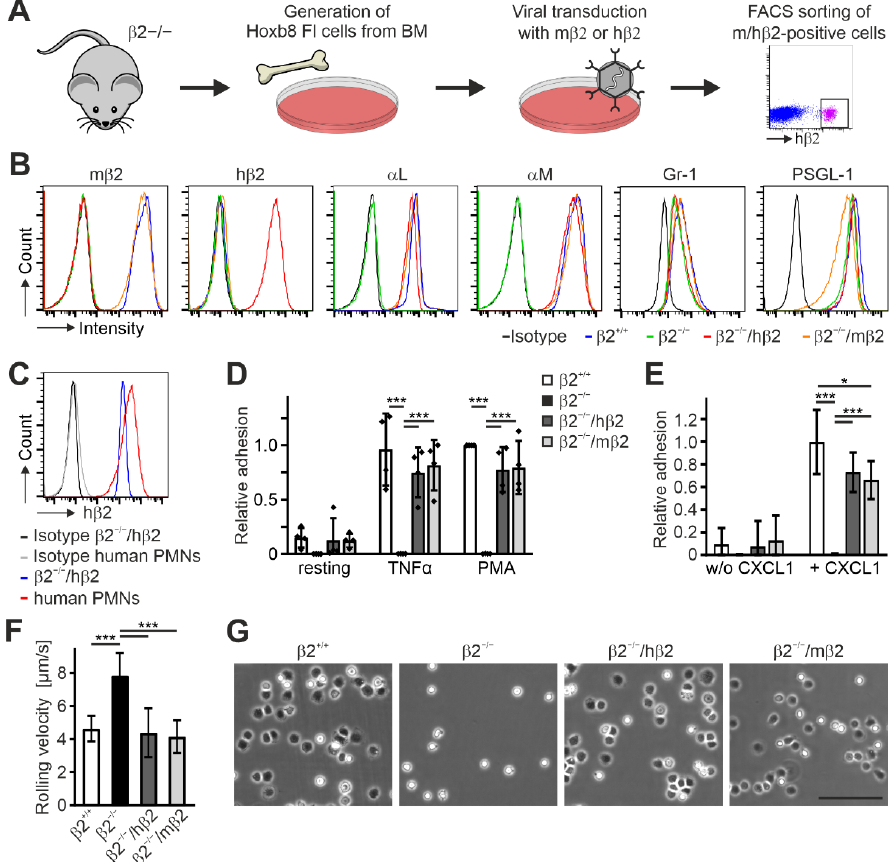
Figure 1. Integrin β 2 can be substituted by its human homolog in mouse Hoxb8 FL cells. ( A ) Scheme of workflow. Hoxb8 FL cells were generated from bone marrow of integrin β 2-deficient mice and retrovirally transduced with mouse or human integrin β 2. Human/mouse integrin β 2-positive cells were FACS-sorted. ( B ) Surface expression of different integrin subunits and cell markers on neutrophil-like cells differentiated from control ( β 2 +/+ ), integrin β 2 ko ( β 2 − / − ), and human or mouse integrin β 2-rescued integrin β 2 − / − ( β 2 − / − /h β 2 and β 2 − / − /m β 2) Hoxb8 FL cells assessed by FACS analysis. ( C ) Integrin β 2 surface expression levels on neutrophil-like cells differentiated from integrin β 2 − / − Hoxb8 FL cells retrovirally transduced with human integrin β 2 ( β 2 − / − /h β 2) compared to PMNs isolated from human blood. ( D ) Static adhesion of untreated, TNF α -treated, or PMA-treated Hoxb8 FL-derived β 2 +/+ , β 2 − / − , β 2 − / − /h β 2, and β 2 − / − /m β 2 neutrophils on ICAM1. N = 4. Individual data points of the 4 independent experiments are shown. ( E , F ) Adhesion ( E ) and rolling velocities ( F ) of neutrophil-like cells differentiated from β 2 +/+ , β 2 − / − , β 2 − / − /h β 2, and β 2 − / − /m β 2 Hoxb8 FL cells in flow chambers coated with ICAM1 and P-selectin with or without CXCL1 under constant shear rate of 1 dyn/cm 2 . N = 10/11 chambers with CXCL1 (rolling and adhesion); N = 3/4 without CXCL1 (adhesion). ( G ) Neutrophil-like β 2 +/+ , β 2 − / − , β 2 − / − /h β 2, and β 2 − / − /m β 2 cells plated on a P-selectin-, ICAM1-, and CXCL1-coated surface for 10 min. Scale bar: 100 µ m. All values are given as mean ± SD. * p < 0.05, *** p < 0.001. Next, we analyzed cell adhesion, spreading, and β 2 integrin-mediated signaling in Hoxb8 cell-derived macrophages that express either mouse or human β 2 integrin. These cells and macrophages differentiated from Hoxb8- β 2 +/+ cells showed, like PMN-LCs, comparable integrin surface levels, whereas flow cytometry confirmed no α L and α M integrin surface expression on β 2 integrin-deficient macrophages (Figure S1). As expected, macrophage adhesion to the β 1 and β 3 integrin ligand fibronectin was comparable between all cells, and both Hoxb8- β 2 − / − /h β 2- and Hoxb8- β 2 − / − /m β 2-derived macrophages showed a similar adhesion to ICAM1 as macrophages differentiated from Hoxb8- β 2